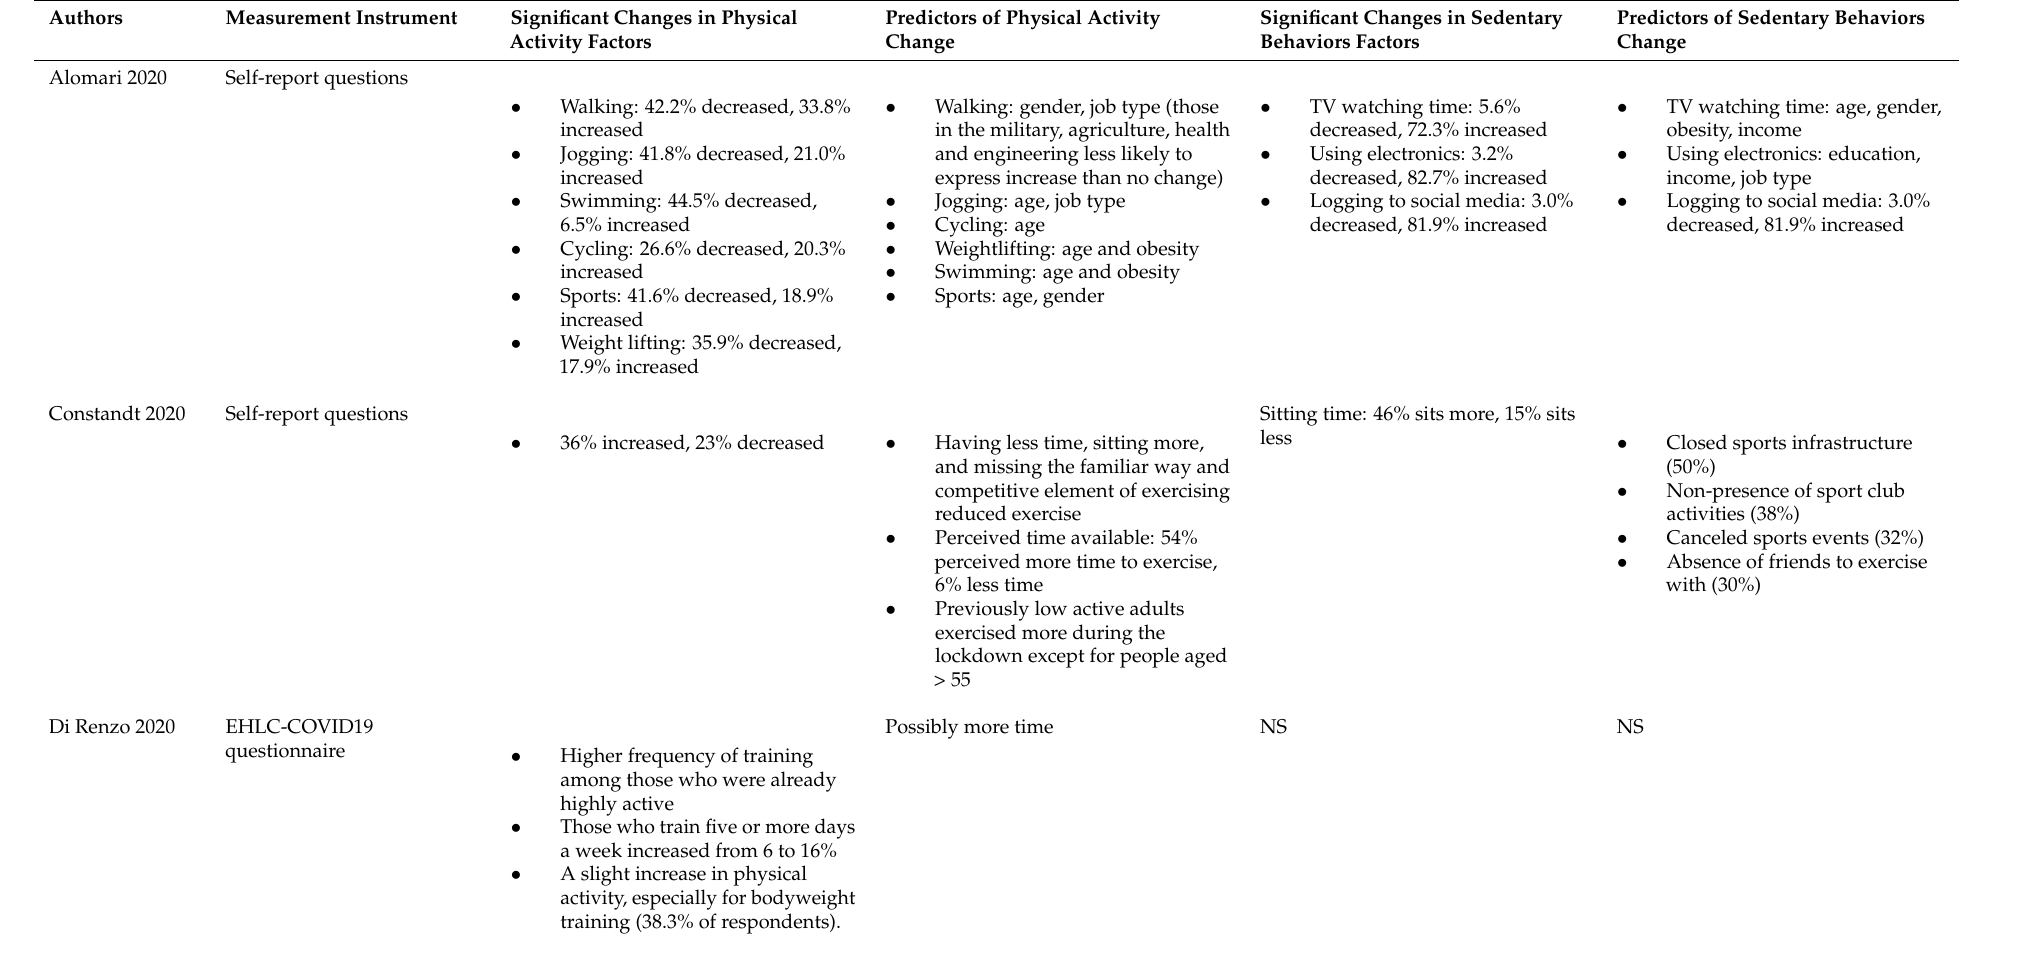
Table 5. Changes in physical activity behaviors and the corresponding predictors during the COVID-19